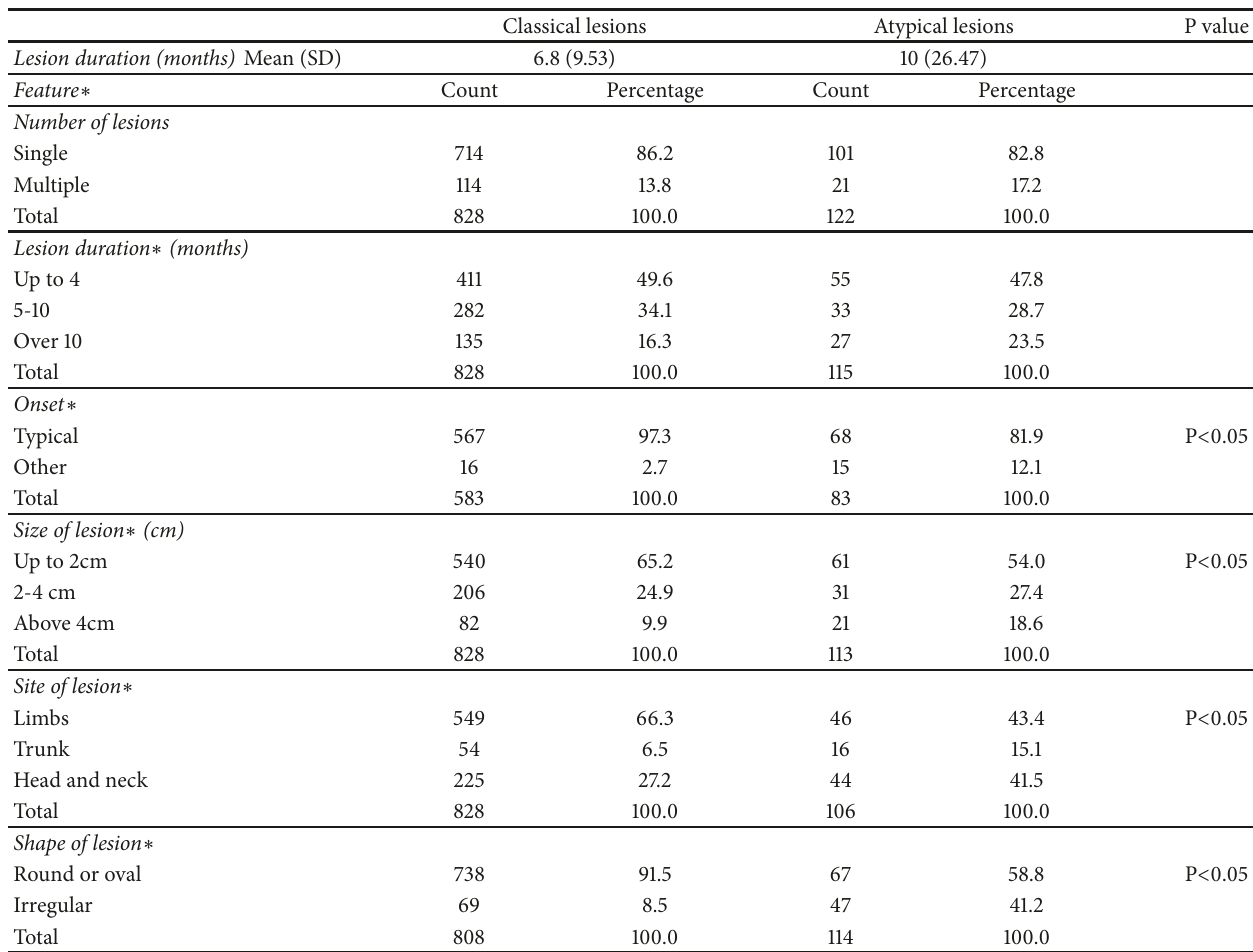
Table 2: Clinical characteristics of typical and atypical lesions in the study population. Classical